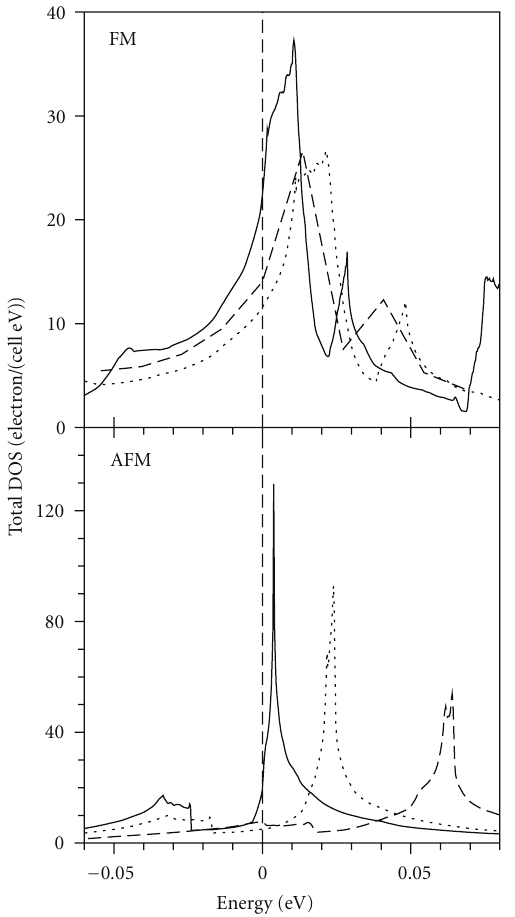
Figure 71: Expanded view of the DOS of TmSe (solid line), TmS (dotted line), and TmSe with the lattice constant of TmS (dashed line) calculated in the LSDA+ U approximation for ferromagnetic (FM) and antiferromagnetic (AFM) ordering [384].